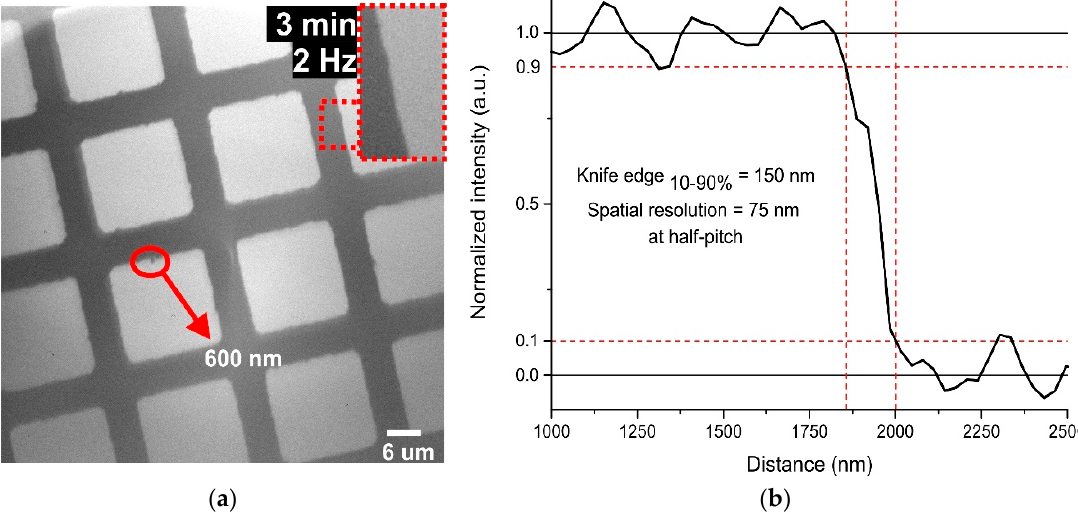
Figure 4. ( a ) Soft X-ray image of copper mesh 1000 lines/inch acquired with 3 min exposure time (360 SXR pulses). A red, dashed rectangle highlights a sharp edge representing the place where the spatial resolution was calculated. Scale bar is 6 µm. ( b ) Knife-edge resolution test results showing normalized intensity profile across a sharp edge. A 10 – 90% intensity transition corresponding to Rayleigh resolution is equal to 150 nm, half-pitch spatial resolution equal to 75 nm, measured from the image of the Cu mesh.